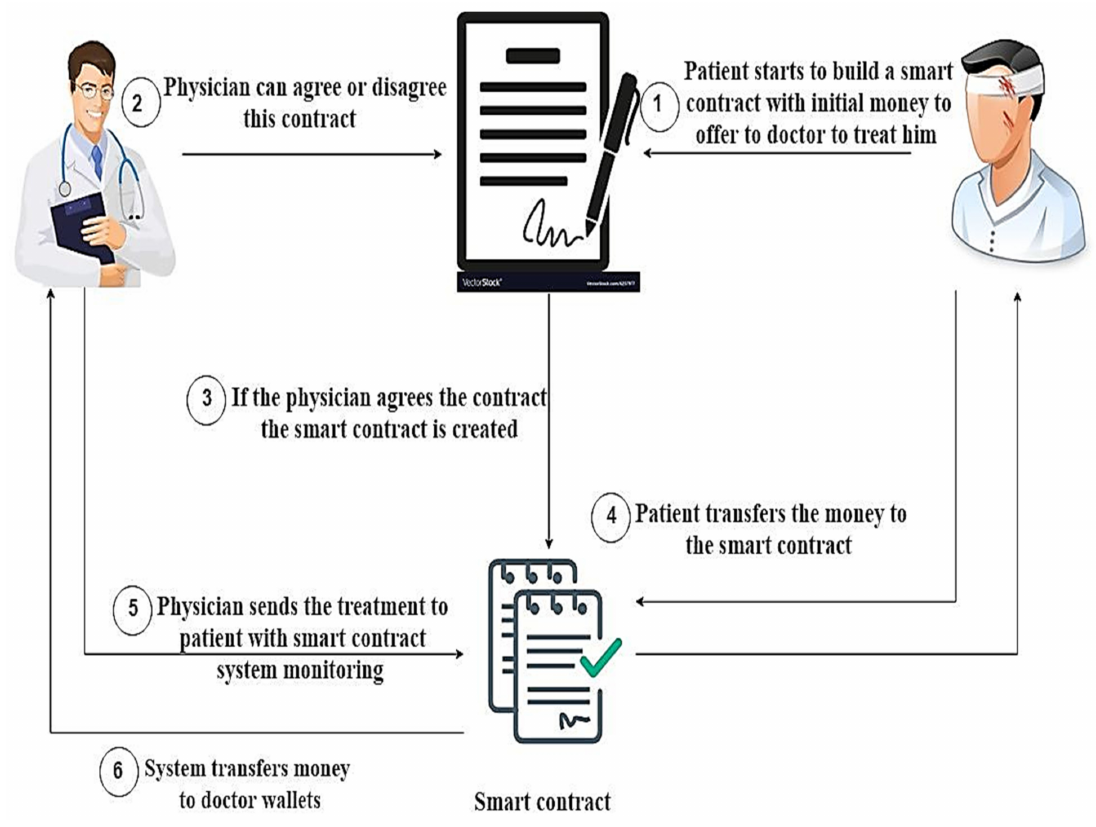
Figure 4. Operations of the smart